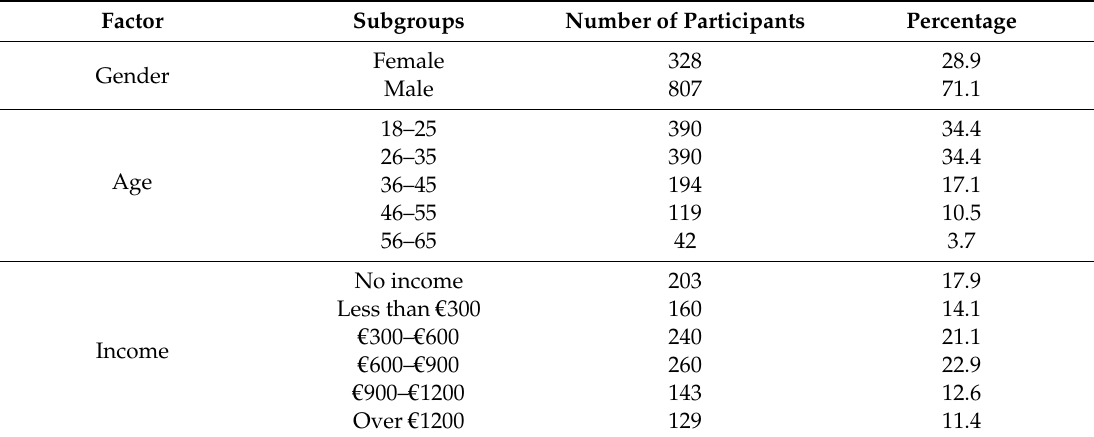
Table 1. Socio-economic characteristics of the